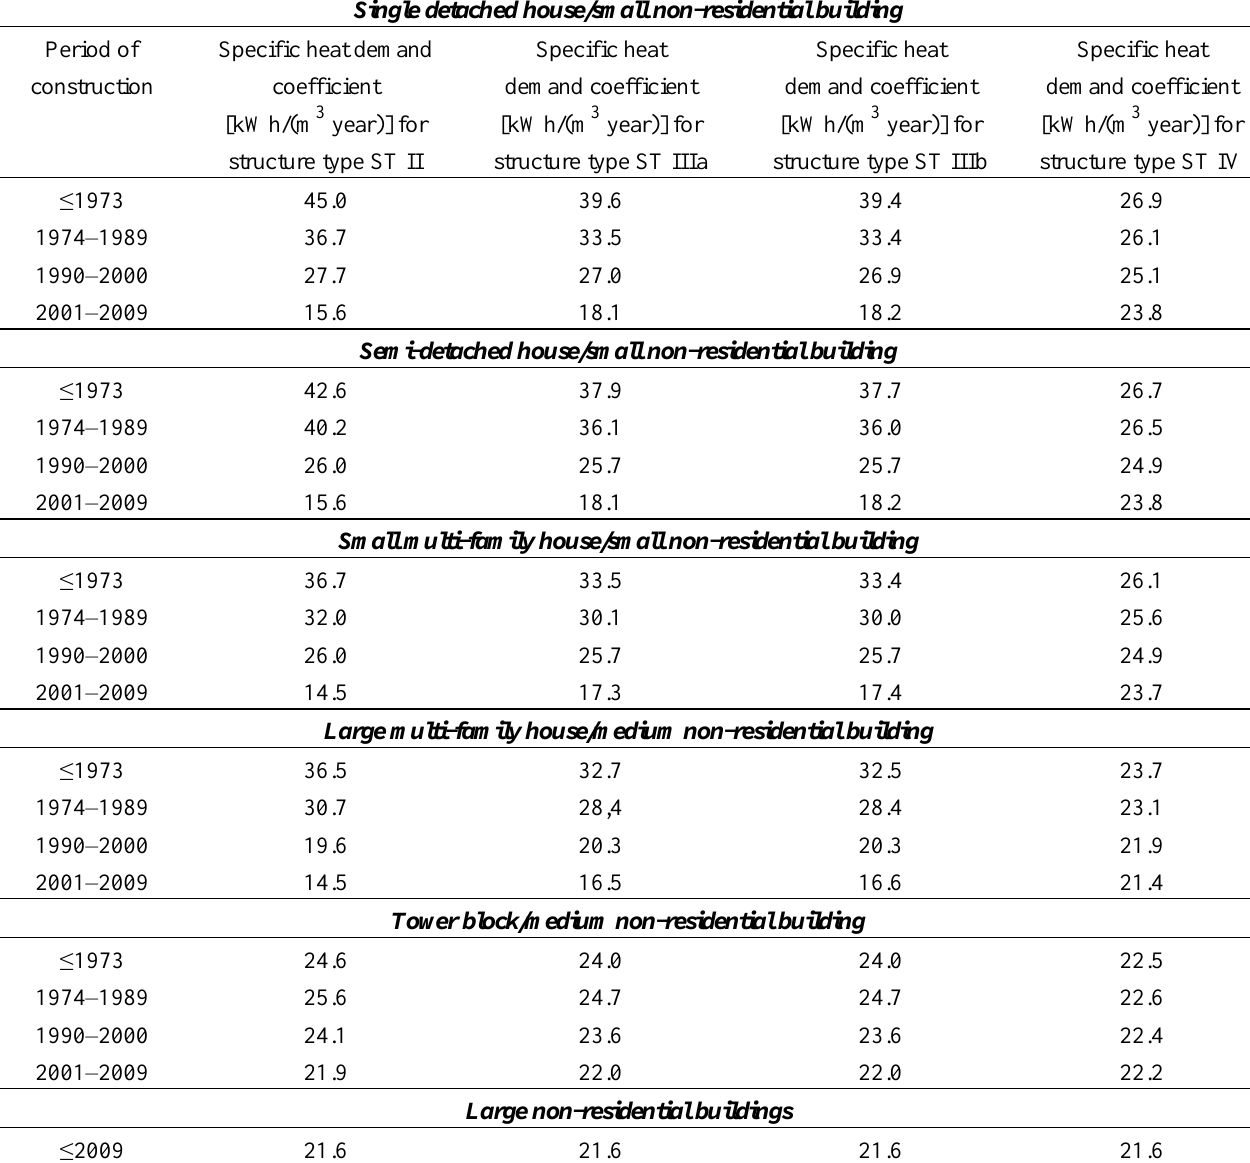
Table 3. Specific heat demand coefficients vary as a function of building type, structural type and period of